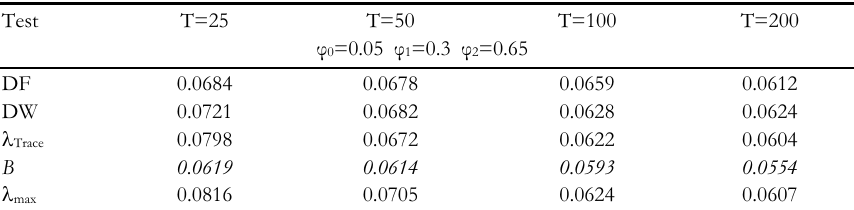
Proportion of rejects ( (cid:438) 0 =0.05 (cid:438) Proportions of rejects out of 5000 tests, nominal level 0.95